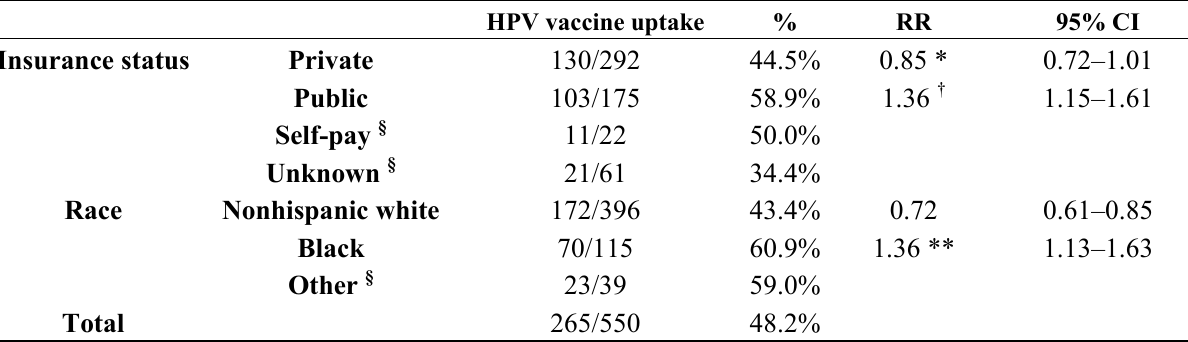
Table 2. Human papillomavirus (HPV) vaccine uptake (≥1 dose received) by insurance and race in population of 11–12 year old girls presenting for well child visits between May 2008–April